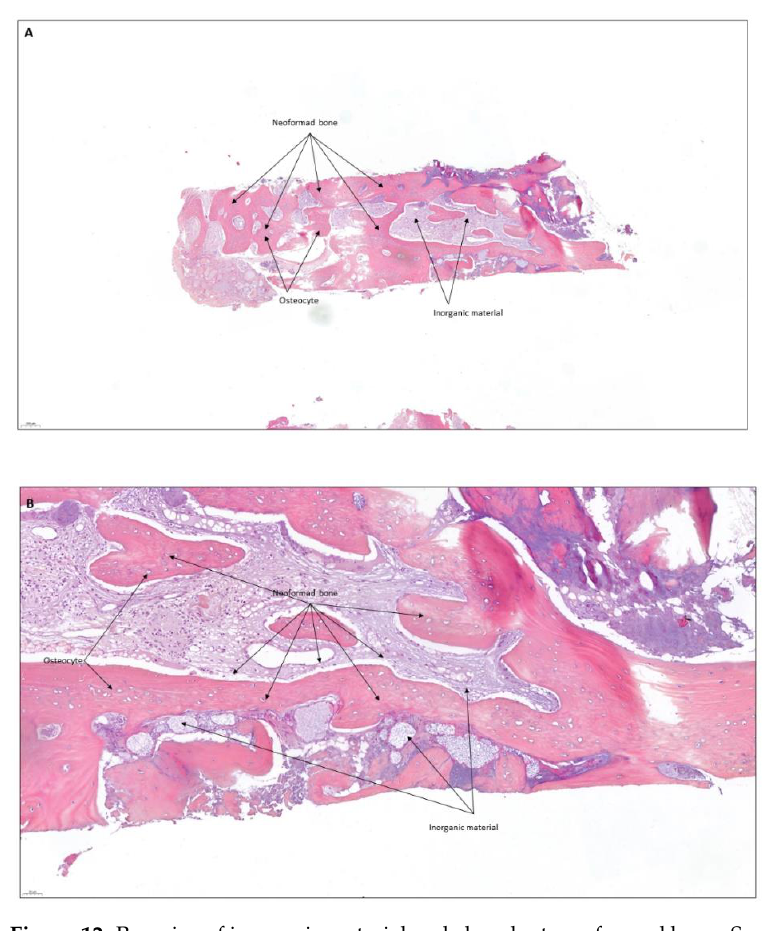
Figure 12. Remains of inorganic material and abundant newformed bone. Some degree of spinal cord fibrosis. ( A ) at 50 × and ( B ) at 200 × .Total bone length is 4.7 mm and newformed bone is 2.34